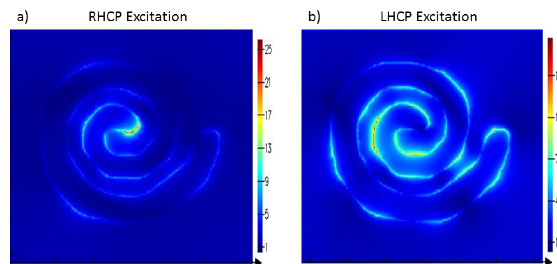
Figure 5: a) FDTD simulations of the focusing mode of the nanospiral using a right-handed circularly polarized excitation (b) and left- handed circularly polarized